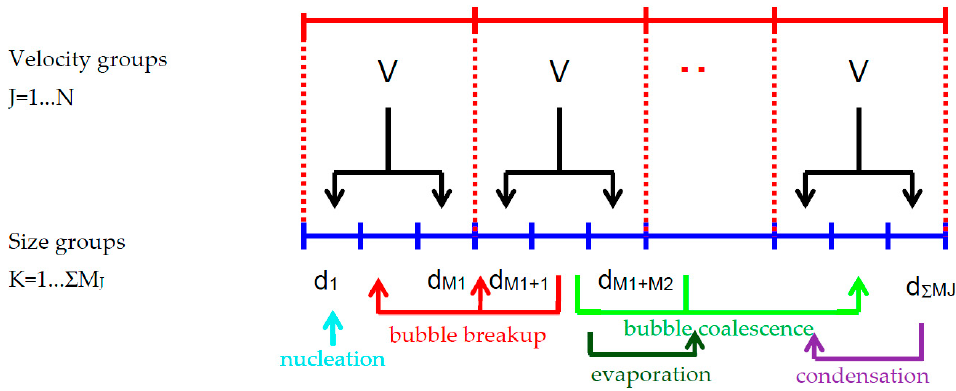
Figure 11. Schema of the inhomogeneous multiple size group (MUSIG) model.